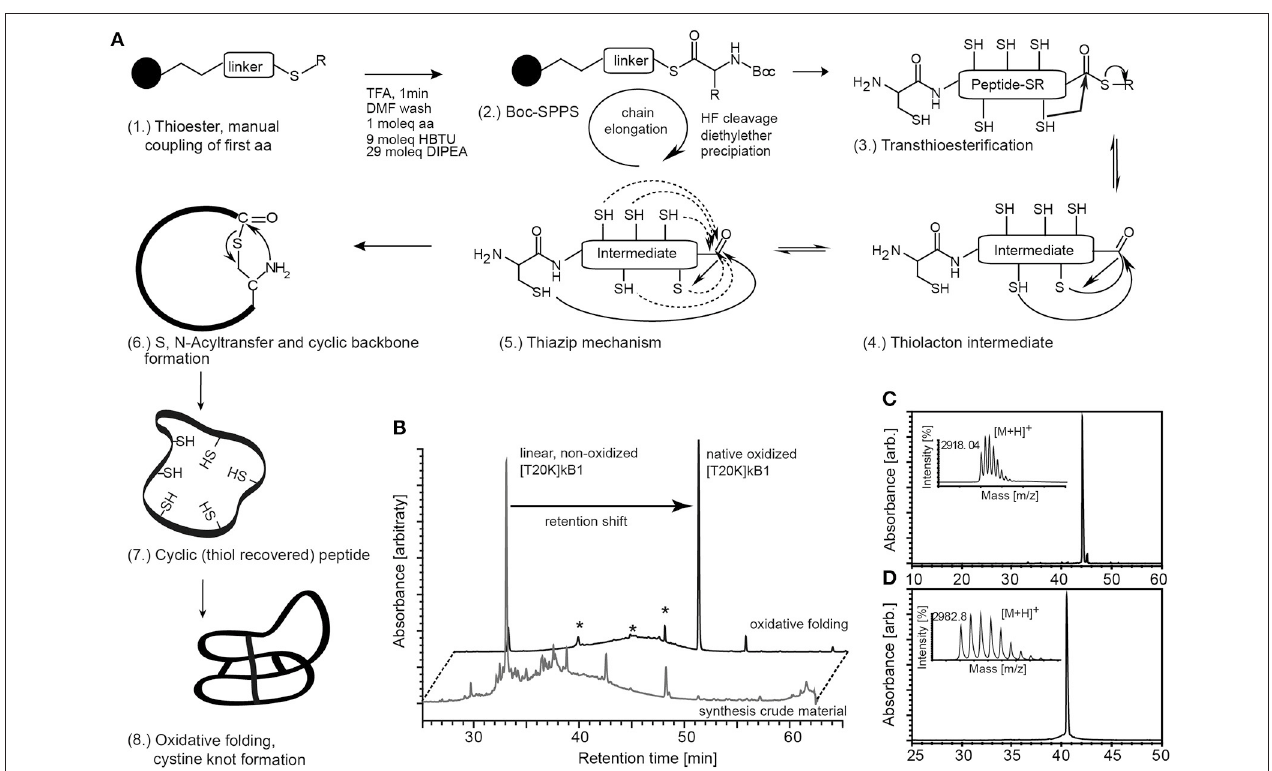
FIGURE 1 | Synthesis of circular peptide probes. (A) (1.) Cyclotides and probes were synthesized as linear thioester precursor peptides using a Boc-solid-phase peptide synthesis protocol. (2.) Peptide precursor was released from the resin and globally de-protected by hydrogen fluoride (HF) treatment. The cyclic native folded peptide was obtained after native chemical ligation potentially supported via the thia-zip mechanism described for cysteine-rich peptides in oxidative folding conditions. (3., 4.) Transthioesterification forms an intramolecular thiolactone intermediate. (5.) The proposed thia-zip mechanism brings the N-terminal cysteine residue in close proximity to the C-terminal thiolactone intermediate. (6., 7.) An irreversible S,N-acylshift forms a native peptide bond and recovers all thiols. (8.) The native cystine-knot fold is achieved in oxidative folding buffers. (B) Native folded cyclotides exhibit a shift in chromatographic retention compared to its reduced progenitor and all identified non-native folded species (marked with asterisks) as indicated by the A 280 UV traces of the peptide before and after oxidative folding. Synthesized and oxidative folded cyclotide probes [T20K]kB1 (C) and [T20K,W23Bpa]kB1 (D) were purified via preparative HPLC and evaluated for their molecular weight using MALDI-TOF mass spectrometry and for purity by analytical HPLC analysis. Mass spectra and UV chromatograms (A 280 ) are presented. Retention time and molecular weight (monoisotopic [M + H] + ) are indicated (small